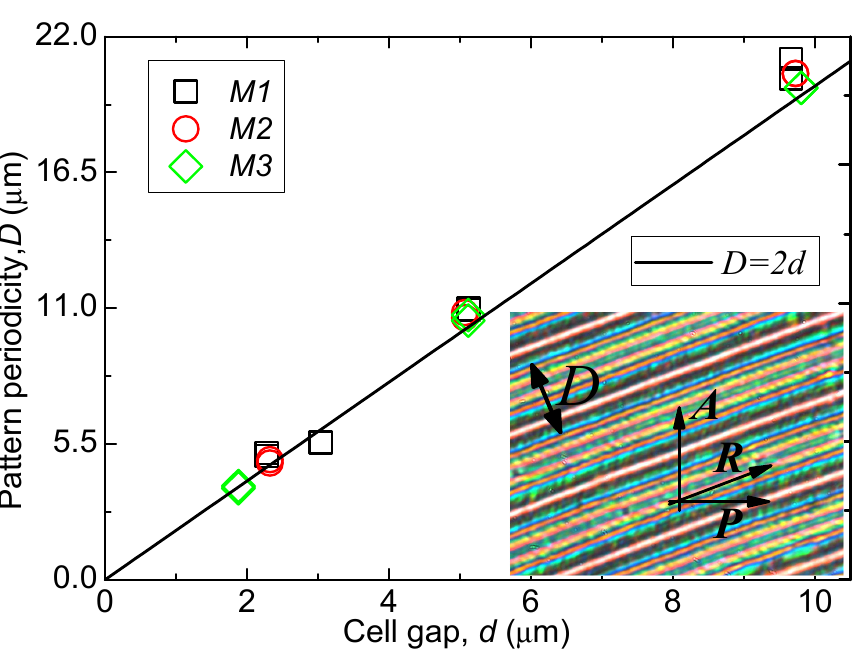
Figure 10. Pattern periodicity plotted as a function of the cell gap varying from 2 to 10 µm. A cell for each thickness is planarly aligned and similarly prepared. Materials used are M1, M2 and M3. The inset in the figure shows beautiful stripes [15].